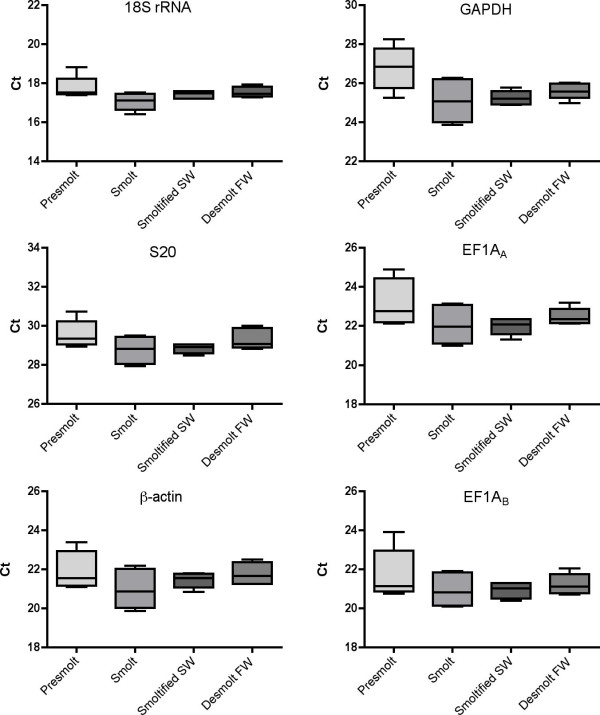
qRT-PCR analysis of six genes in gills of six Atlantic salmon going through smoltification; presmolt (before smoltification), smolt (during smoltification), smoltified (finished smoltified in seawater) and desmolt (desmoltification in freshwater). Numbers indicate raw Ct values.